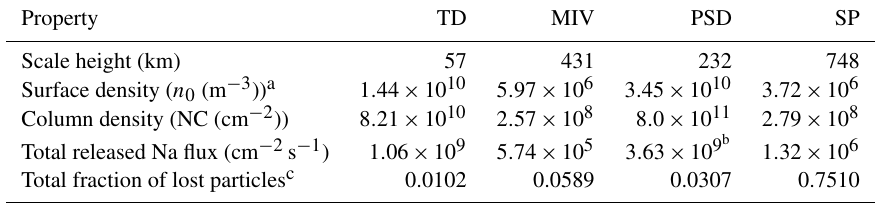
Table 2. Results from the MC simulation.